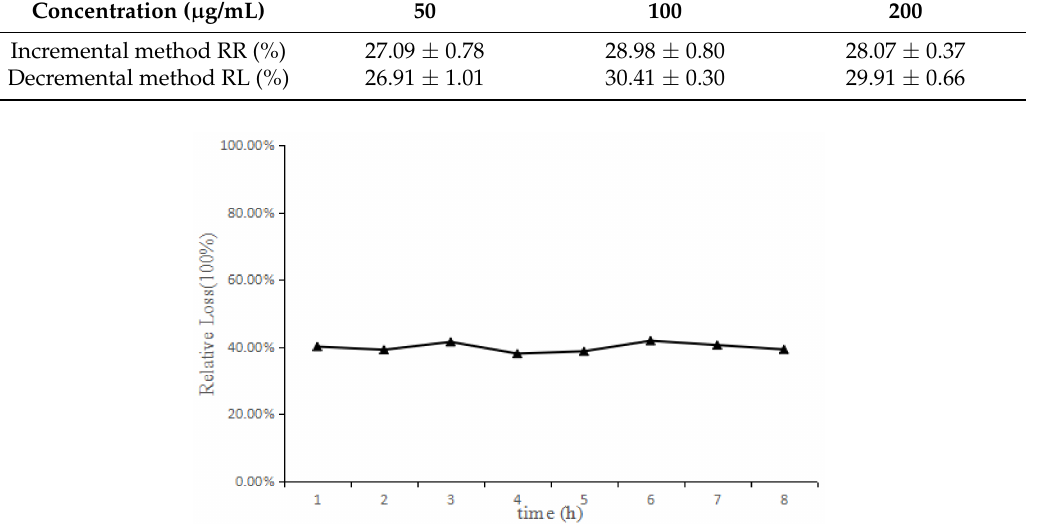
Figure 1. The stability of RL of knee-joint microdialysis probes in vivo ( n = 4, x ± s ). (The probe was perfused with Ringer containing GE (100 µ g/mL) at a flow rate of 1 µ L/min. The analytic samples were collected every l h to investigate the stability of the microdialysis probe in vivo over 8 h. Calculations for the joint microdialysis probe were made according to the reduction method formula: R in vivo = (C perfusate − C dialysis )/C perfusate ×